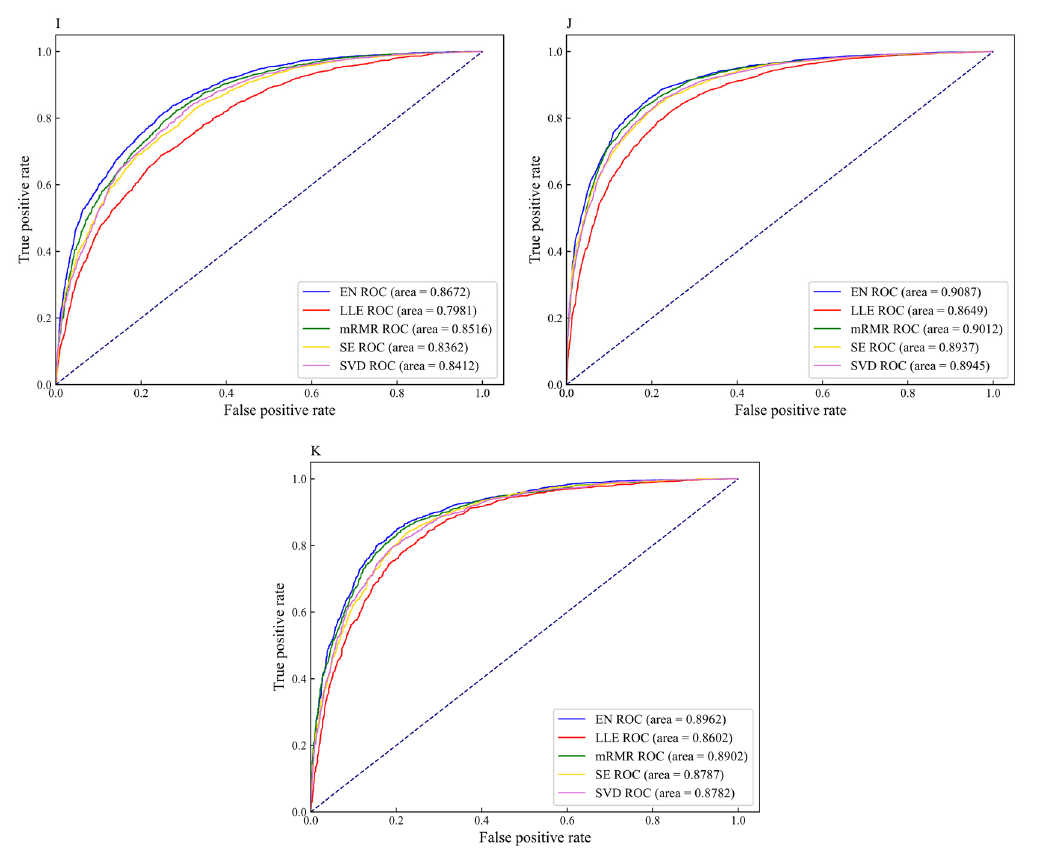
Figure 6. The receiver operator characteristic (ROC) curves of different feature selection methods on eleven datasets ( A ) H_B, ( B ) H_K, ( C ) H_L, ( D ) M_B, ( E ) M_H, ( F ) M_K, ( G ) M_L, ( H ) M_T, ( I ) R_B, ( J ) R_K, and ( K ) R_L. Table 5. The performance of models before and after parameter